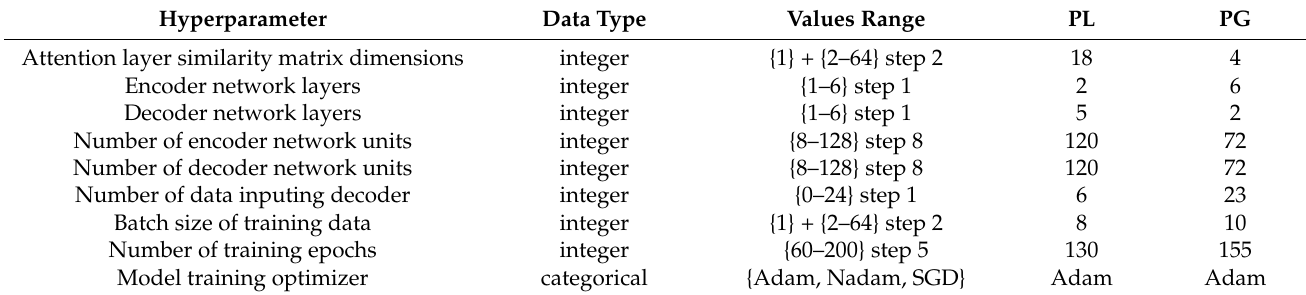
Table 1. Bayesian optimization hyperparameter space and search